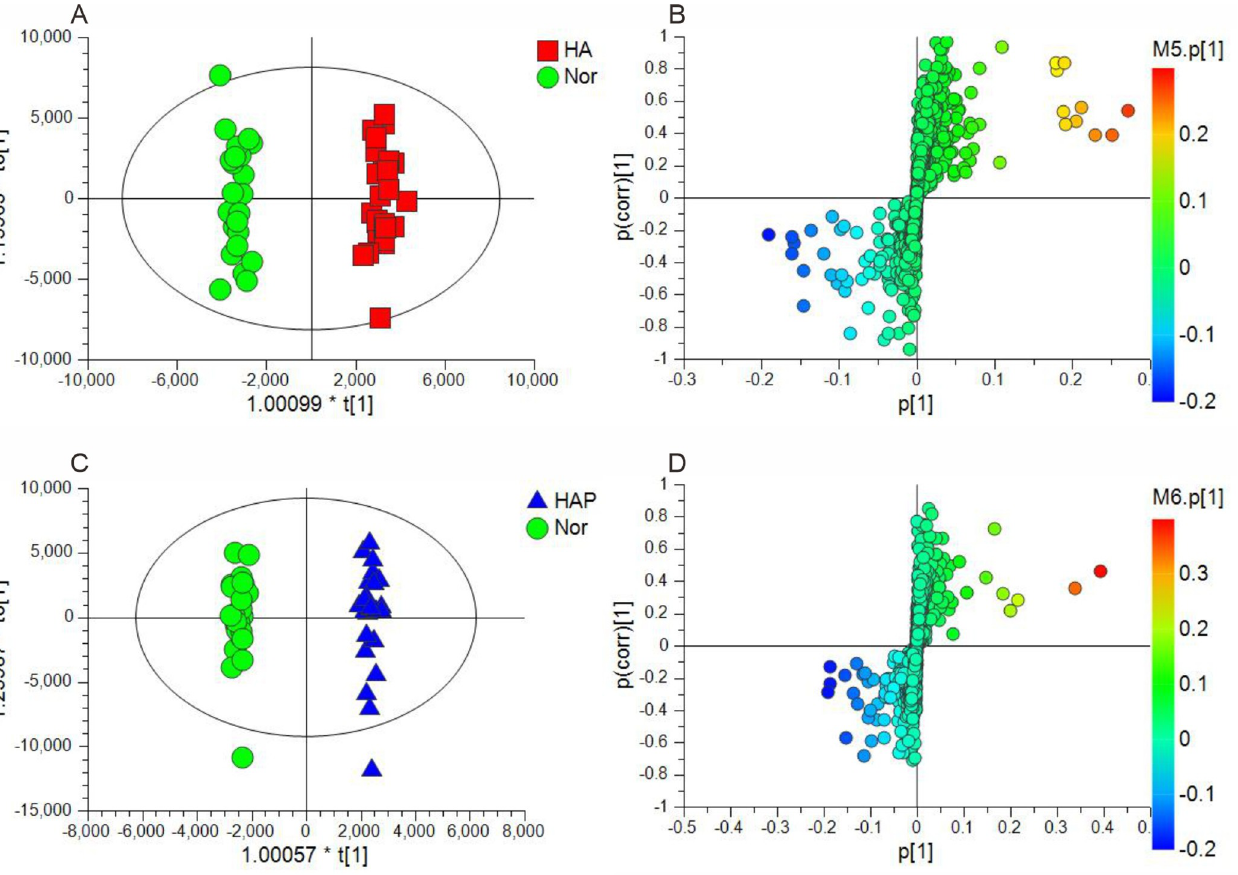
Fig 2. OPLS-DA analysis of the metabolic samples. Panels A and C represents the comparison of the HA and HAP group with the Nor group respectively. Panels B and D are S-Plot diagrams obtained by comparing HA and HAP respectively.